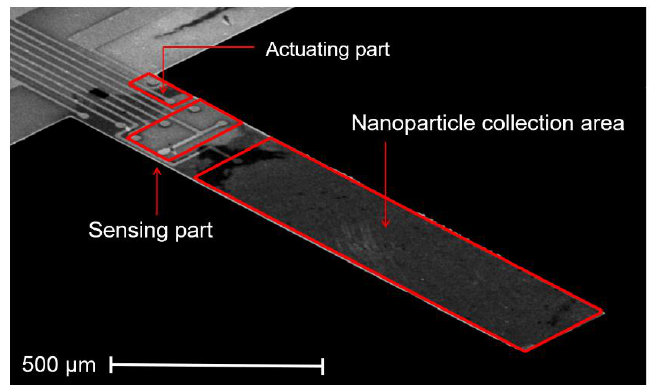
Figure 1. Scanning electron microscopy (SEM) image of the electrothermal piezoresistive cantilever sensor (EtPCS) showing an actuating part and four piezoresistors configured in a full Wheatstone bridge at the clamped end. A p -doped area (740 × 170 µm 2 ) was created on the free-end of the cantilever beam for the collection of carbon nanoparticles.